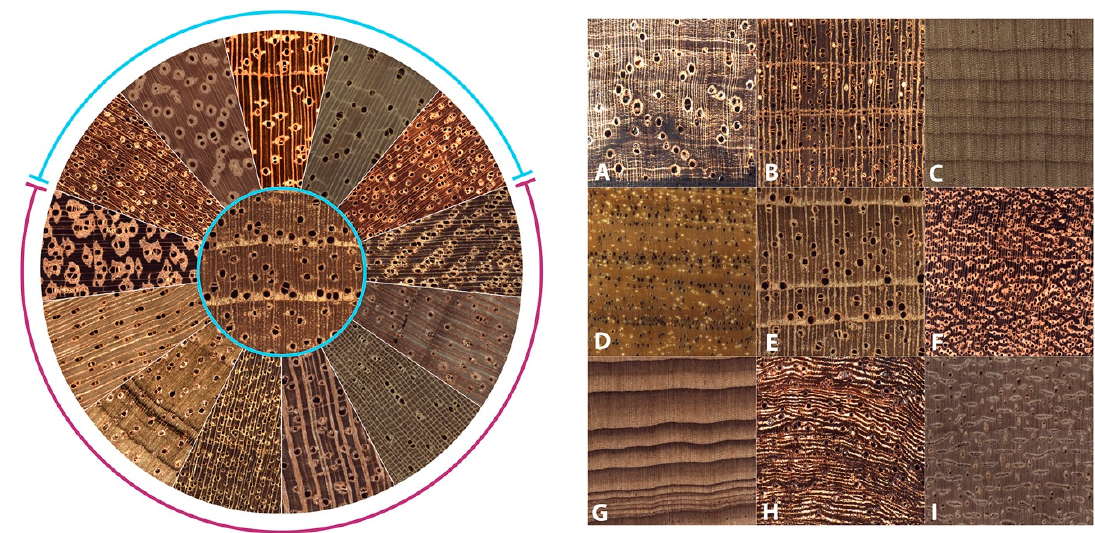
Figure 6. XyloTron images of the transverse surfaces of woods relevant to [58]. Images on the right represent 6.35 mm of tissue on a side; images on the left were captured at the same magnification and resolution. ( Left ): The woods used in [58]. The blue-bordered center image is Cedrela odorata , the single-species CITES-proxy class. The five woods bordered by the blue arc together comprise the non-CITES class. The red-bordered woods are the eight other species used to “test” the binary CITES-proxy vs. non-CITES model. Note that woods bordered by the blue arc are not anatomically similar to Cedrela odorata , but some show anatomical similarity with the woods comprising the non-CITES class. Right: Cedrela odorata ( E ) and eight other CITES-listed woods ( A – D , F – I ). Note that the wood anatomical variability of this small subset of CITES-listed woods is greater than that of the non-CITES woods used in [58]. ( A ), Dalbergia nigra . ( B ), Swietenia macrophylla . ( C ), Araucaria angustifolia . ( D ), Guaiacum sanctum . ( F ), Pericopsis elata . ( G ), Abies guatemalensis . ( H ), Pterocarpus santalinus . ( I ), Aquilaria malaccensis .